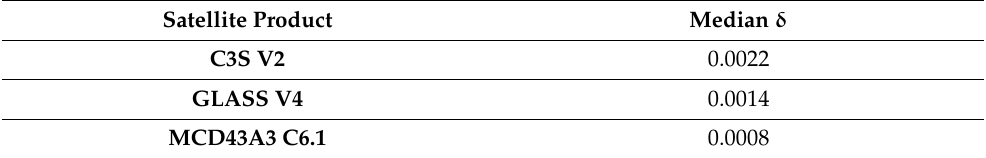
Table 8. Summary of median δ for C3S V2, GLASS V4, and MCD43A3 C6.1 total shortwave black-sky albedo products. Evaluation in the 2001–2005 period over LANDVAL sites considering all pixels.